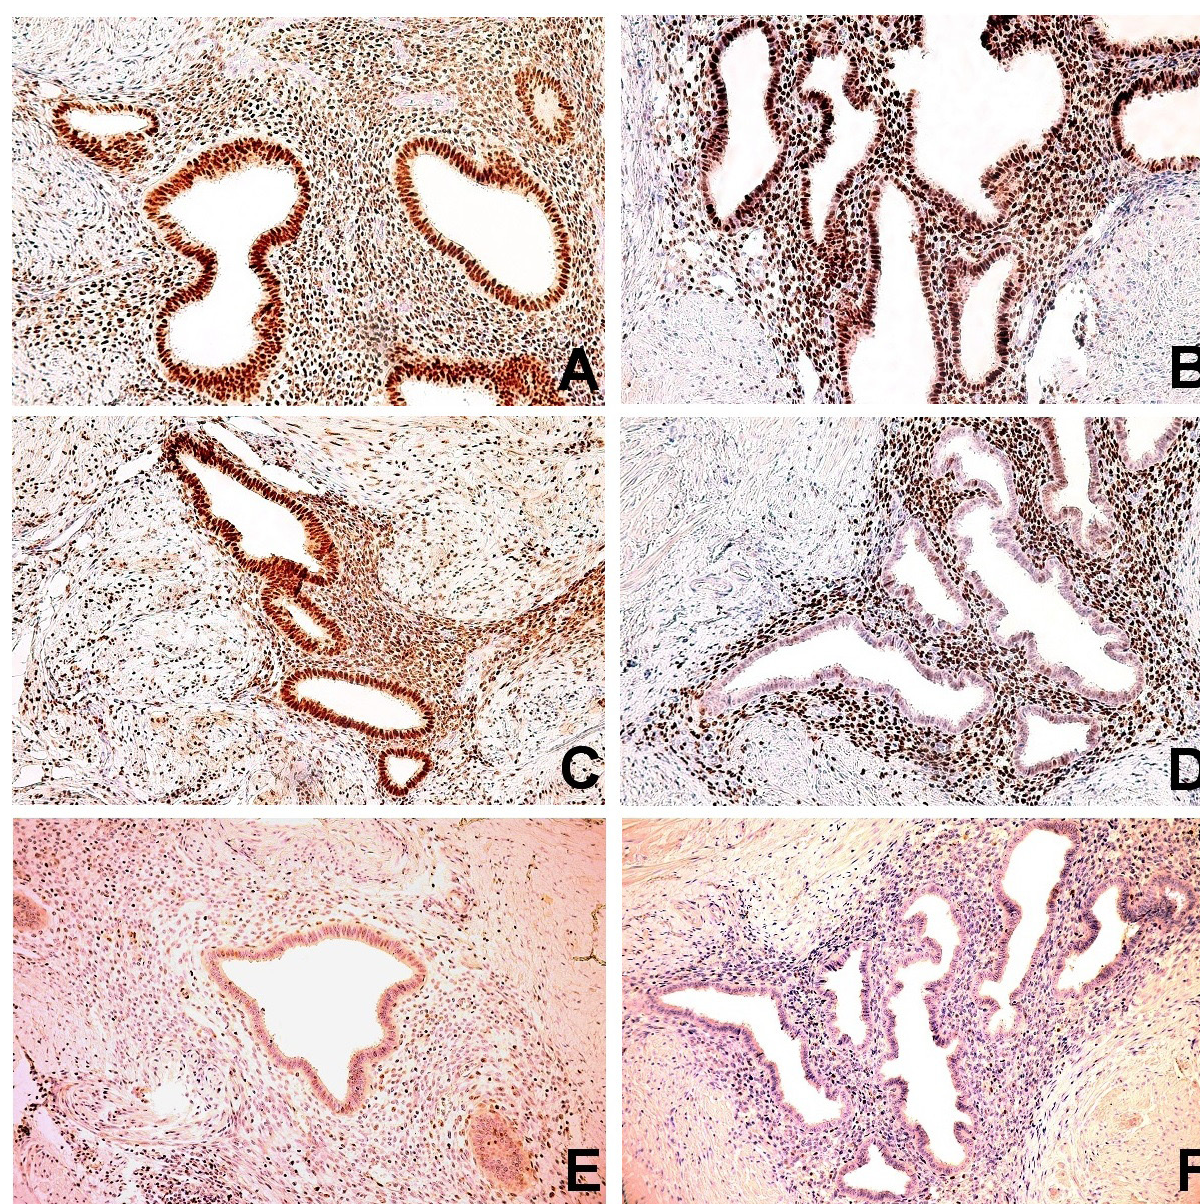
Fig. 4. Immunohistochemical expression of ER, PR and p53 in deep infiltrating endometriosis in the mid proliferative and mid secretory phase of the